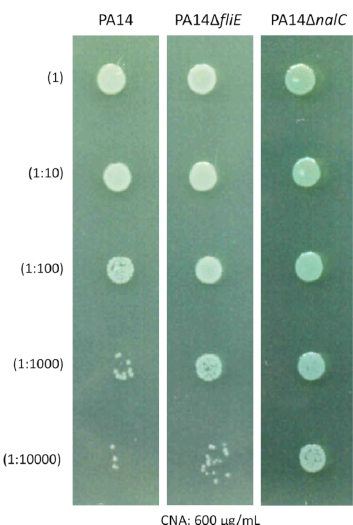
Figure 3. Increased resistance of PA14 ∆ fliE to CNA. Serial Log 10 dilutions of strain PA14 and its derivative mutants PA14 ∆ fliE and PA14 ∆ nalC all calibrated at 0.5 McFarland were spotted onto the surface of an MHA plate containing 600 µ g/mL